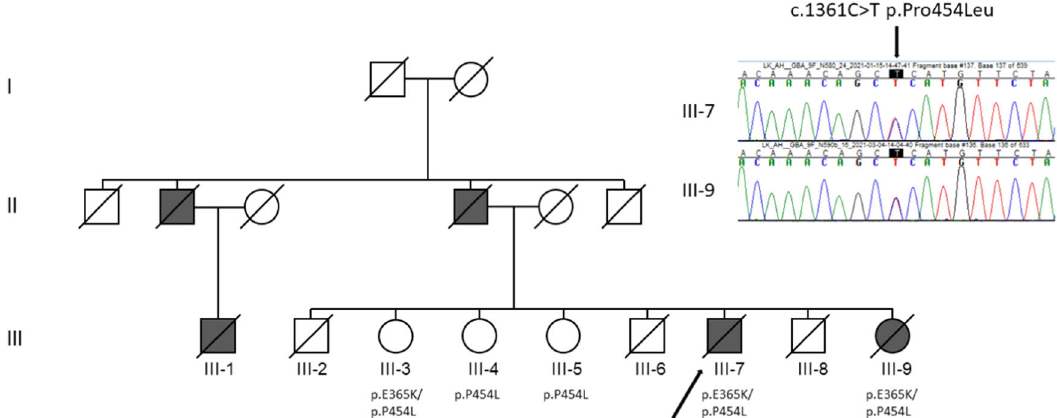
Fig. 1 The pedigree of the affected family. Arrow, the proband; open symbols, healthy persons; solid symbols, affected persons. Chromatograms show the heterozygous nucleotide change leading to the variant p.Pro454Leu.